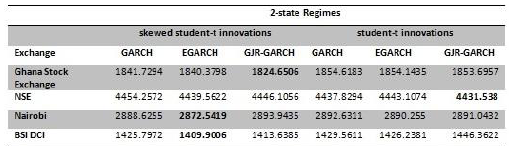
Table 4: DICs for Two-State Regime Switching GARCH Models